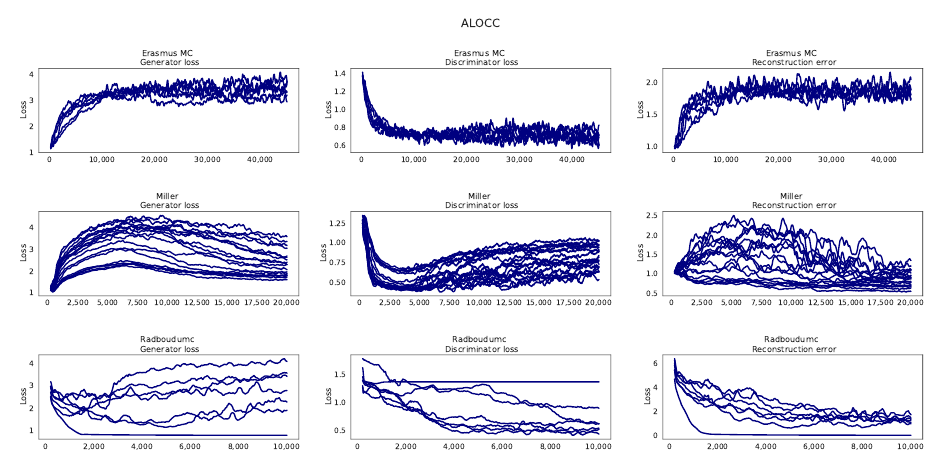
Figure A7. Learning curves for the ALOCC method. The generator, discriminator, and reconstruction loss are displayed in each subplot. Note that each curve represent one